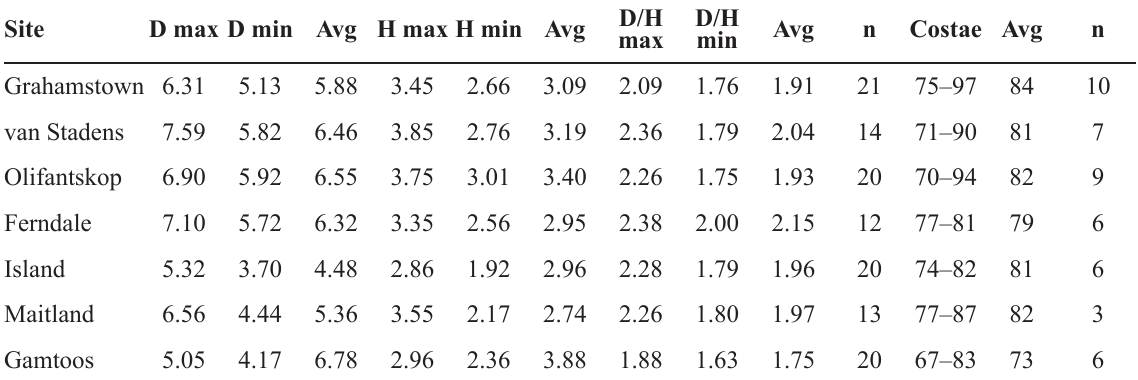
Table 1. Measurements of Chondrocyclus alabastris (Craven, 1880), showing variation between populations; D = shell diameter, H = height, costae = number of axial ribs on body whorl, Avg = average. Site